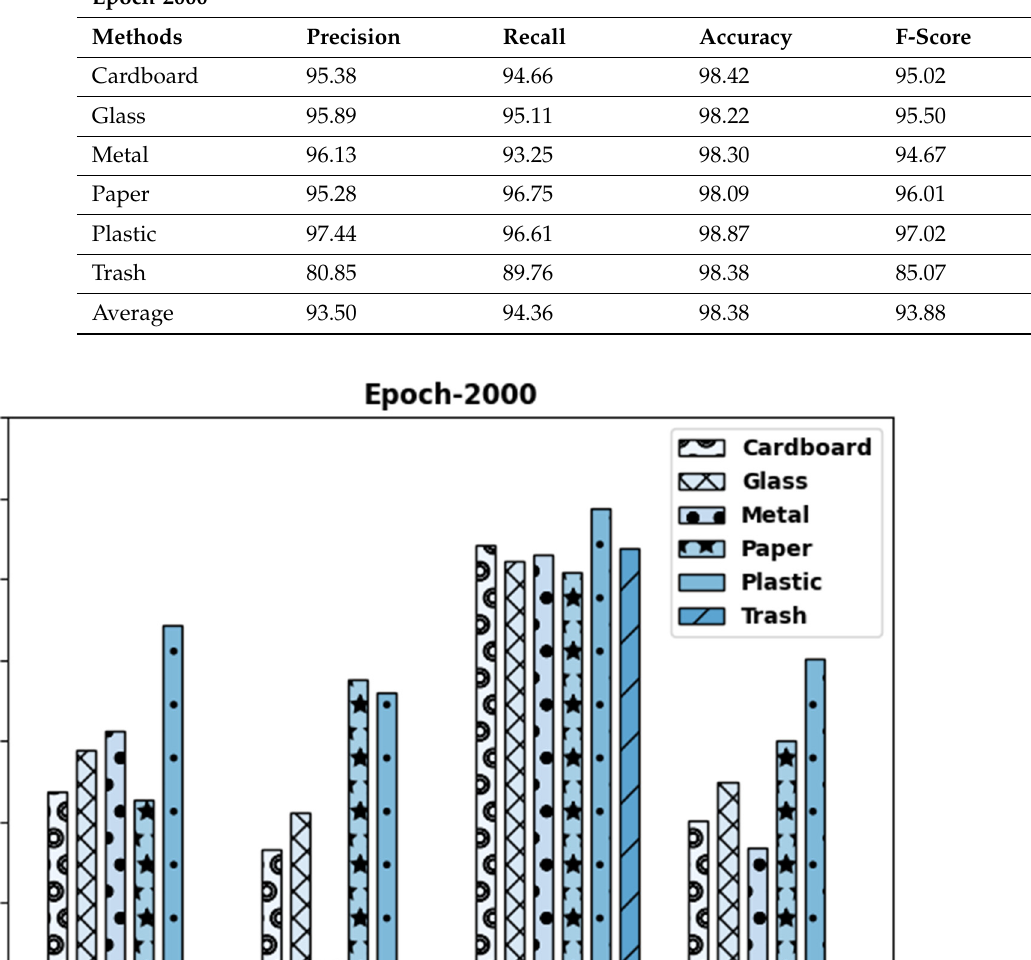
Figure 11. Accuracy graph analysis of DLSODC ‐ GWM technique under 1000 epochs.